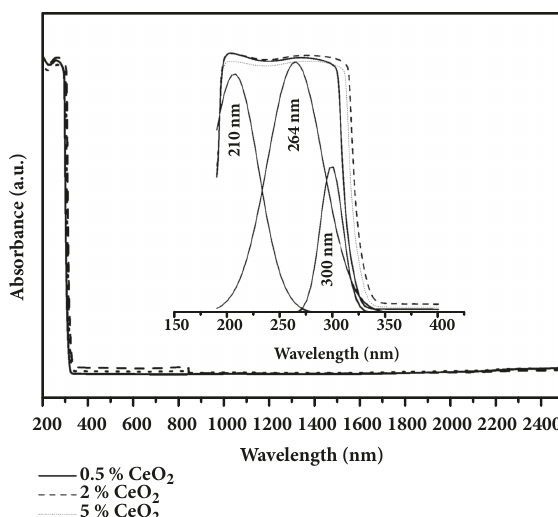
Figure 2: Optical absorption spectra of CeO 2 -doped glasses with the attached deconvoluted spectrum